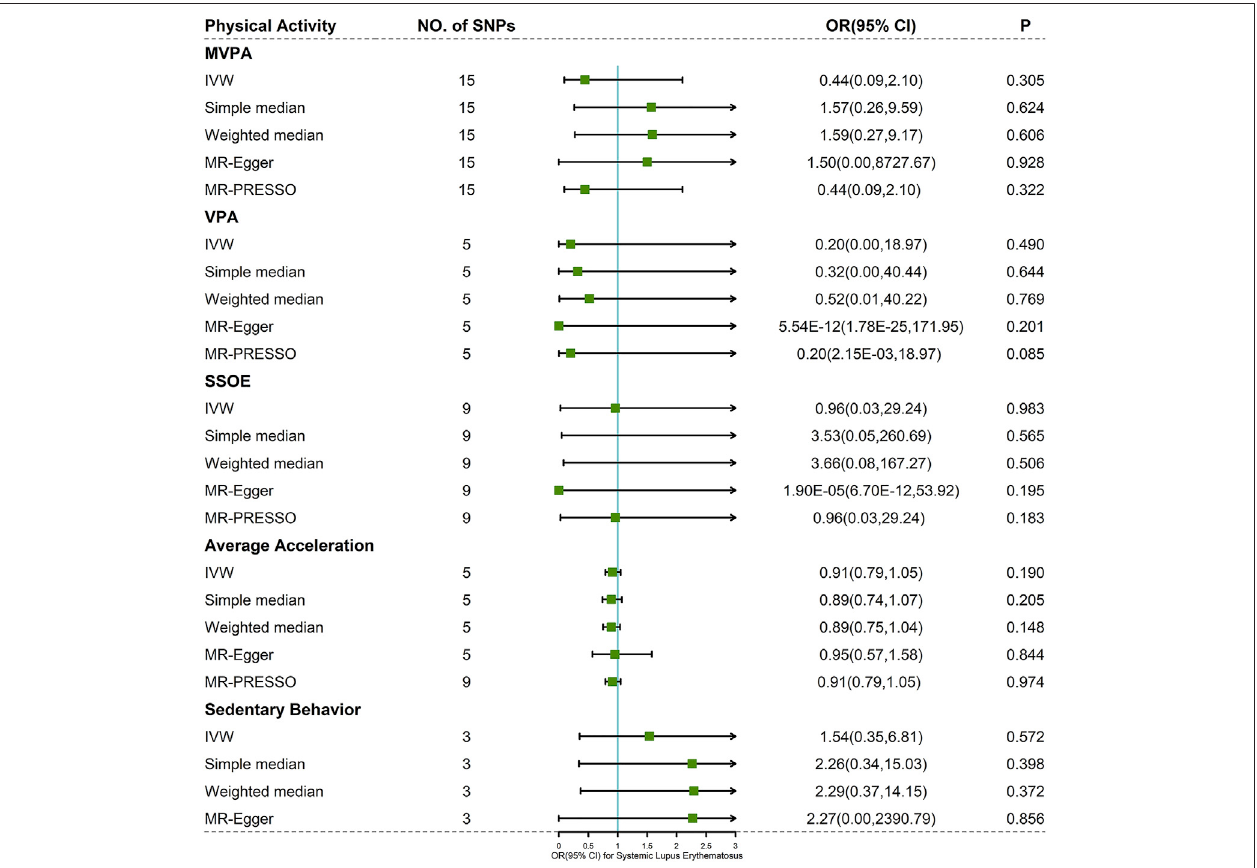
FIGURE 3 | Forest plot of MR analysis for the causal association between PA and SLE. Abbreviations: MVPA, moderate-to-vigorous physical activity; VPA, vigorous physical activity; SSOE, strenuous sports or other exercises; OR, odds ratio; CI, con fi dence interval, IVW, inverse-variance weighted method; MR-Egger, Mendelian randomization-Egger; MR-PRESSO, Mendelian randomization pleiotropy residual sum and outlier test.